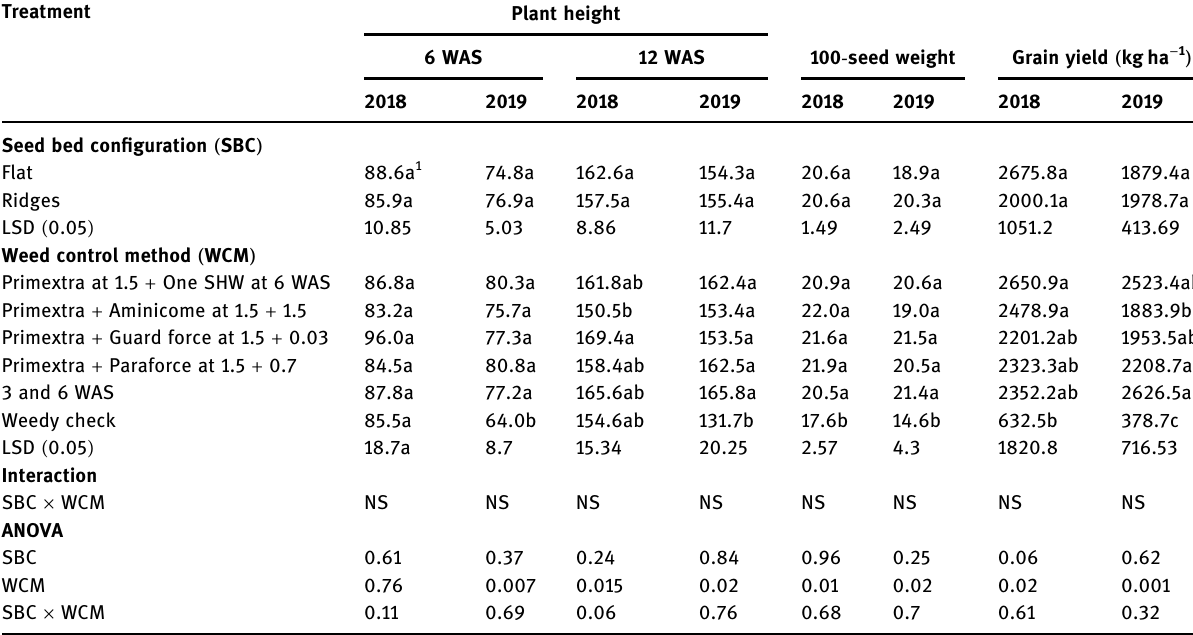
Table 5: E ff ect of seed bed con fi guration and weed control method on agronomic